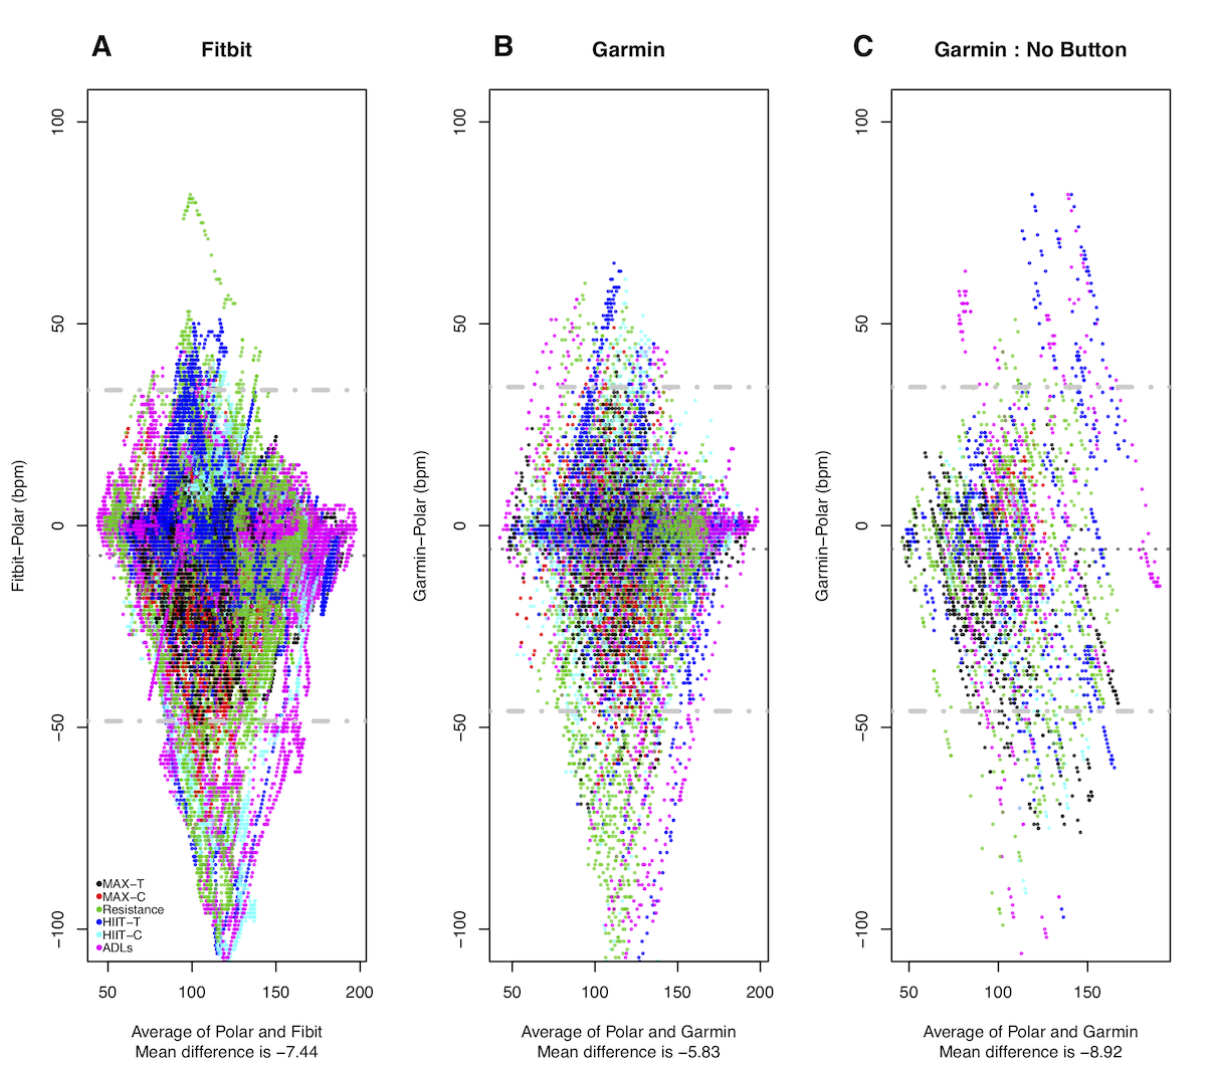
Figure 4. Bland-Altman plots showing heart rate measurements comparing Garmin and Fitbit relative to Polar for all data with activities indicated by color. Mean heart rate is shown on the x-axis, and the difference between the Garmin or Fitbit and the Polar heart rate is on the y-axis. The gray dotted line indicates the mean difference (bias) between the measurement, and the gray dashed lines indicate the limits of agreement. Panel A compares the Fitbit and the Polar. Panel B compares the Garmin (with activity indication) and the Polar. Panel C compares the Garmin (with no activity indication) and the